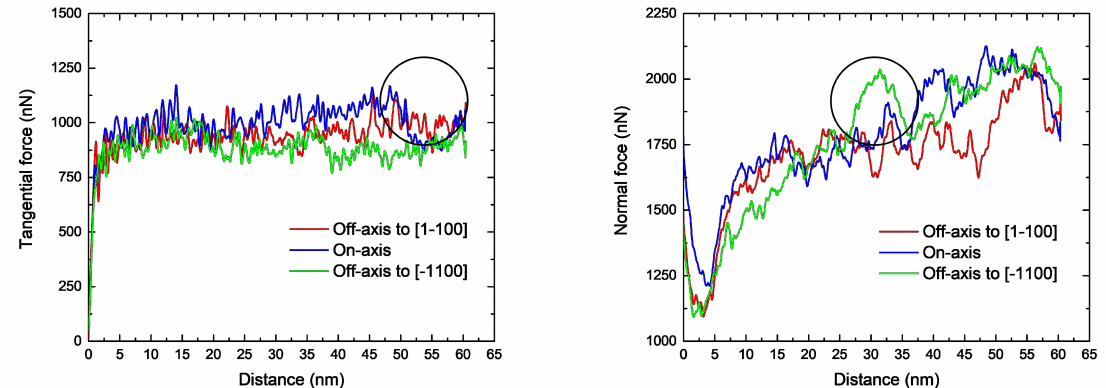
Figure 6. Tangential force and normal force of the cutting with different lattice orientations.